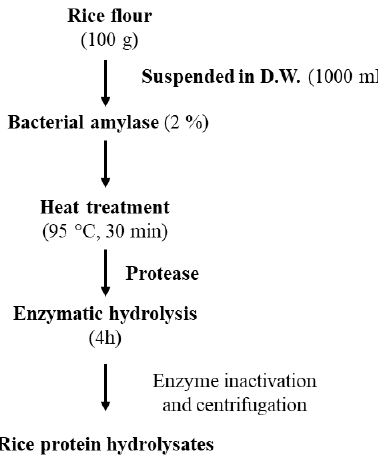
Figure 1. Rice protein hydrolysate preparation flow.